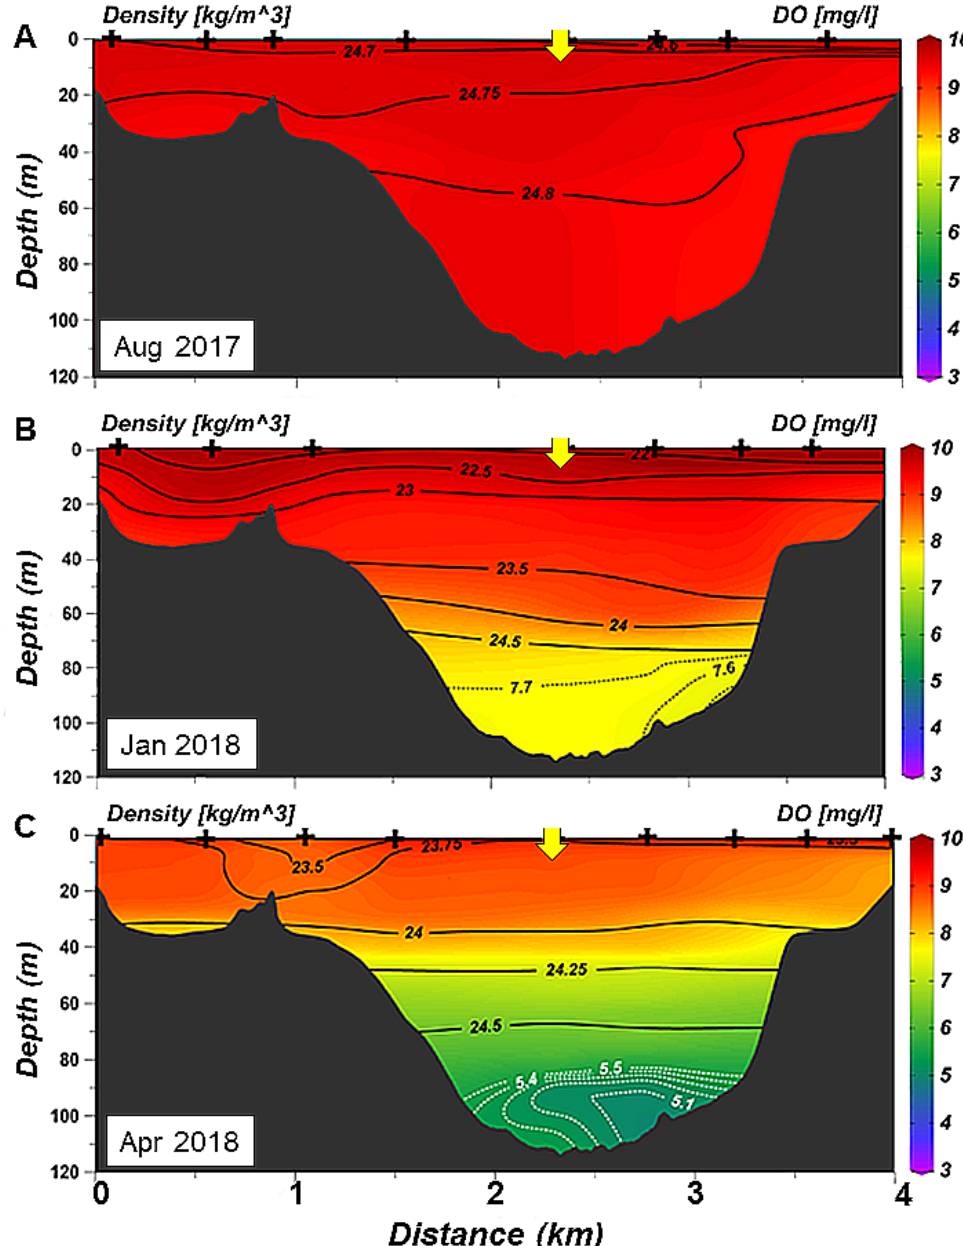
Figure 5. Cross-bay section of DO (color gradient and white isolines at the bottom) and density anomaly (isolines) for ( A ) August 2017; ( B ) January 2018; and ( C ) April 2018. The intersection between cross-bay and along-bay sections is marked with a yellow arrow.